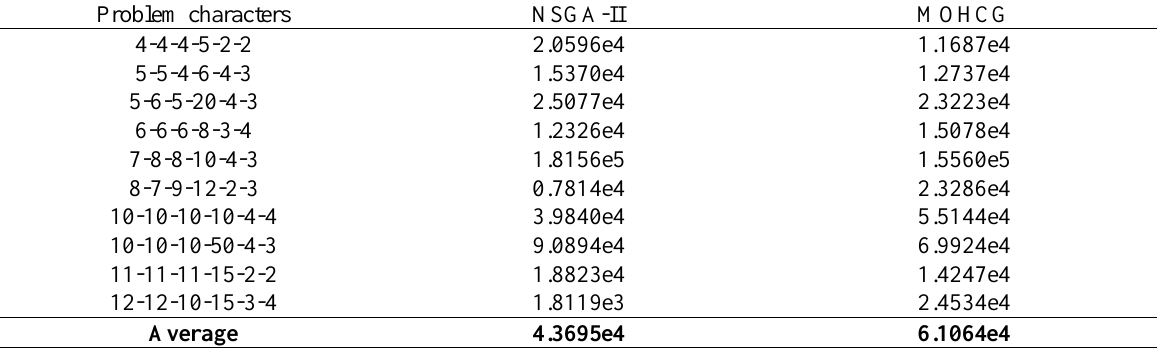
Table 3 . SM measure for small-sized instances Problem characters